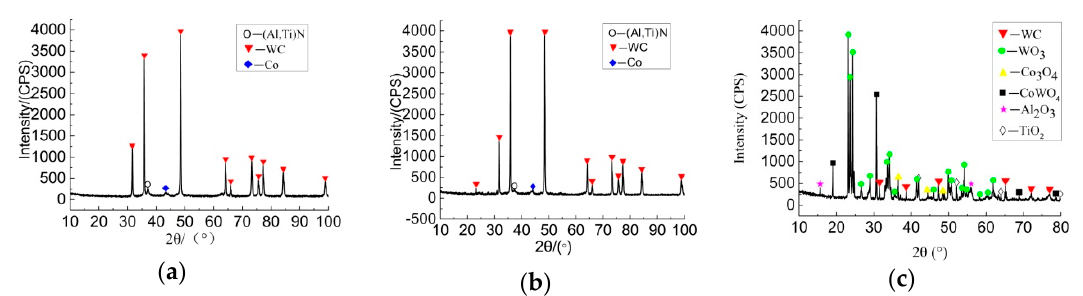
Figure 3. XRD patterns of the coated carbide tool at different temperatures: ( a ) 873 K, WC: PDF#65-4539; Co: PDF#15-0806; (Al, Ti)N: PDF #16-0867; ( b ) 973 K, WC: PDF#65-4539; Co: PDF#15-0806; (Al, Ti)N: PDF #16-0867; ( c ) 1273K, WO 3 : PDF#71-0131; CoWO 4 : PDF#72-0479; WC: PDF#25-1047; TiO 2 : PDF#23-1446; Al 2 O 3 : PDF#16-0394; Co 3 O 4 : PDF#42-1467).